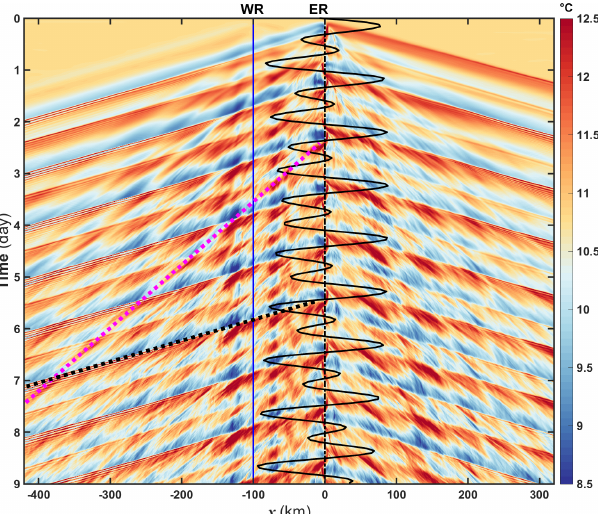
Figure 19. Hovmöller diagram about the global temperature time series at z = 400m, where the time interval is 15min. The black solid curve indicates the tidal current at the east ridge, and the blue solid line means the west ridge location. The black and magenta dashed lines are the first- and second-mode internal solitary